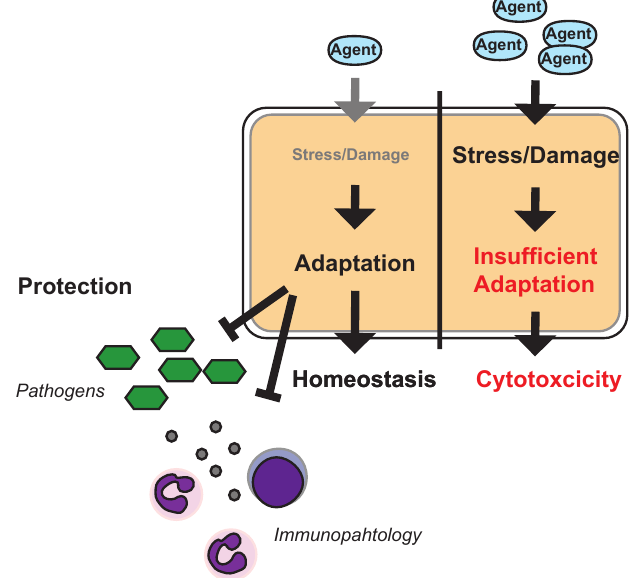
Figure 2. Hormesis and infection: Schematic model of the hormetic response to infection in the parenchyma. High dosages of a given agent (e.g., epirubicin) can impose stress and damage to a cell or organ to an extent that results in insufficient adaptive responses leading to cytotoxicity. Low dosages of the same agent will also impose stress/damage to the cell/organ but allow for adaptation which increases the capacity of the cell/organ to withstand stress/damage imposed by pathogens, their products, i.e., toxins, the immune system (immunopathology), or damage associated molecular patterns such as heme during infections and can in turn provide a pathogen-independent host-targeted approach to treat infectious